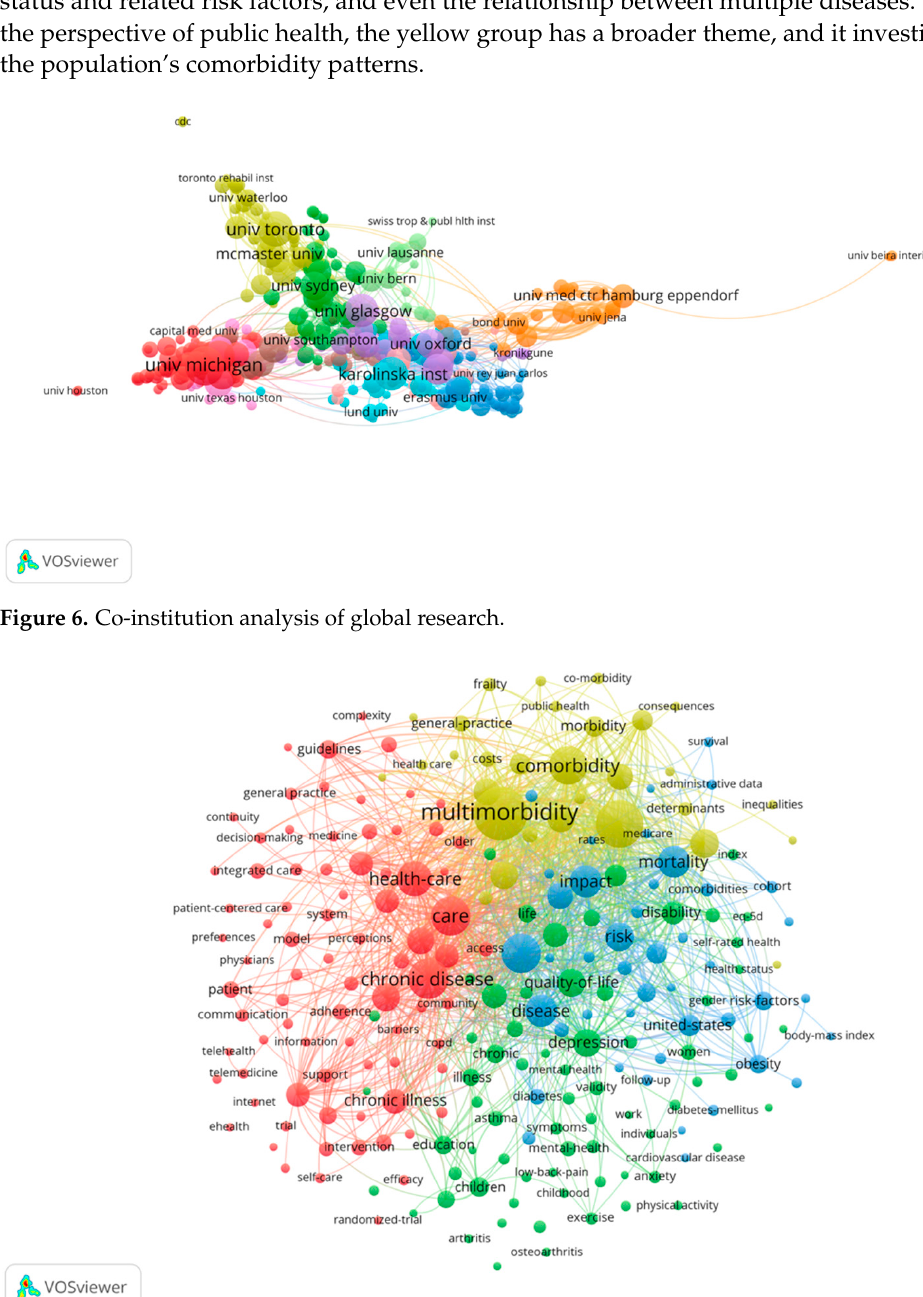
Figure 5. Co-countries analysis of global research.